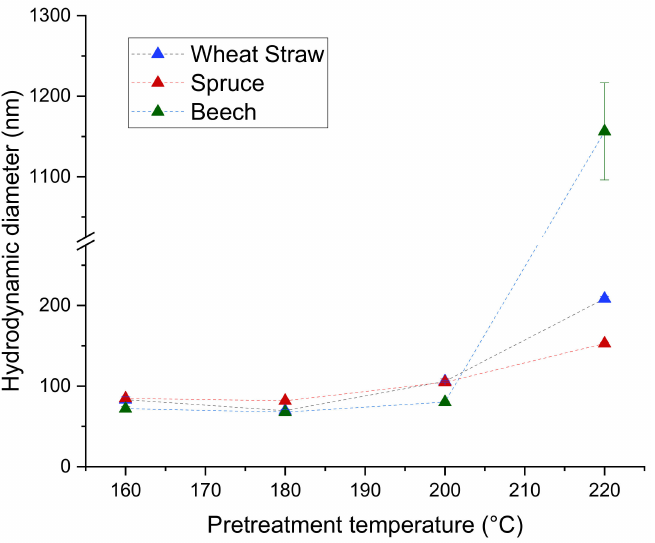
Figure 4. Hydrodynamic diameters of lignin